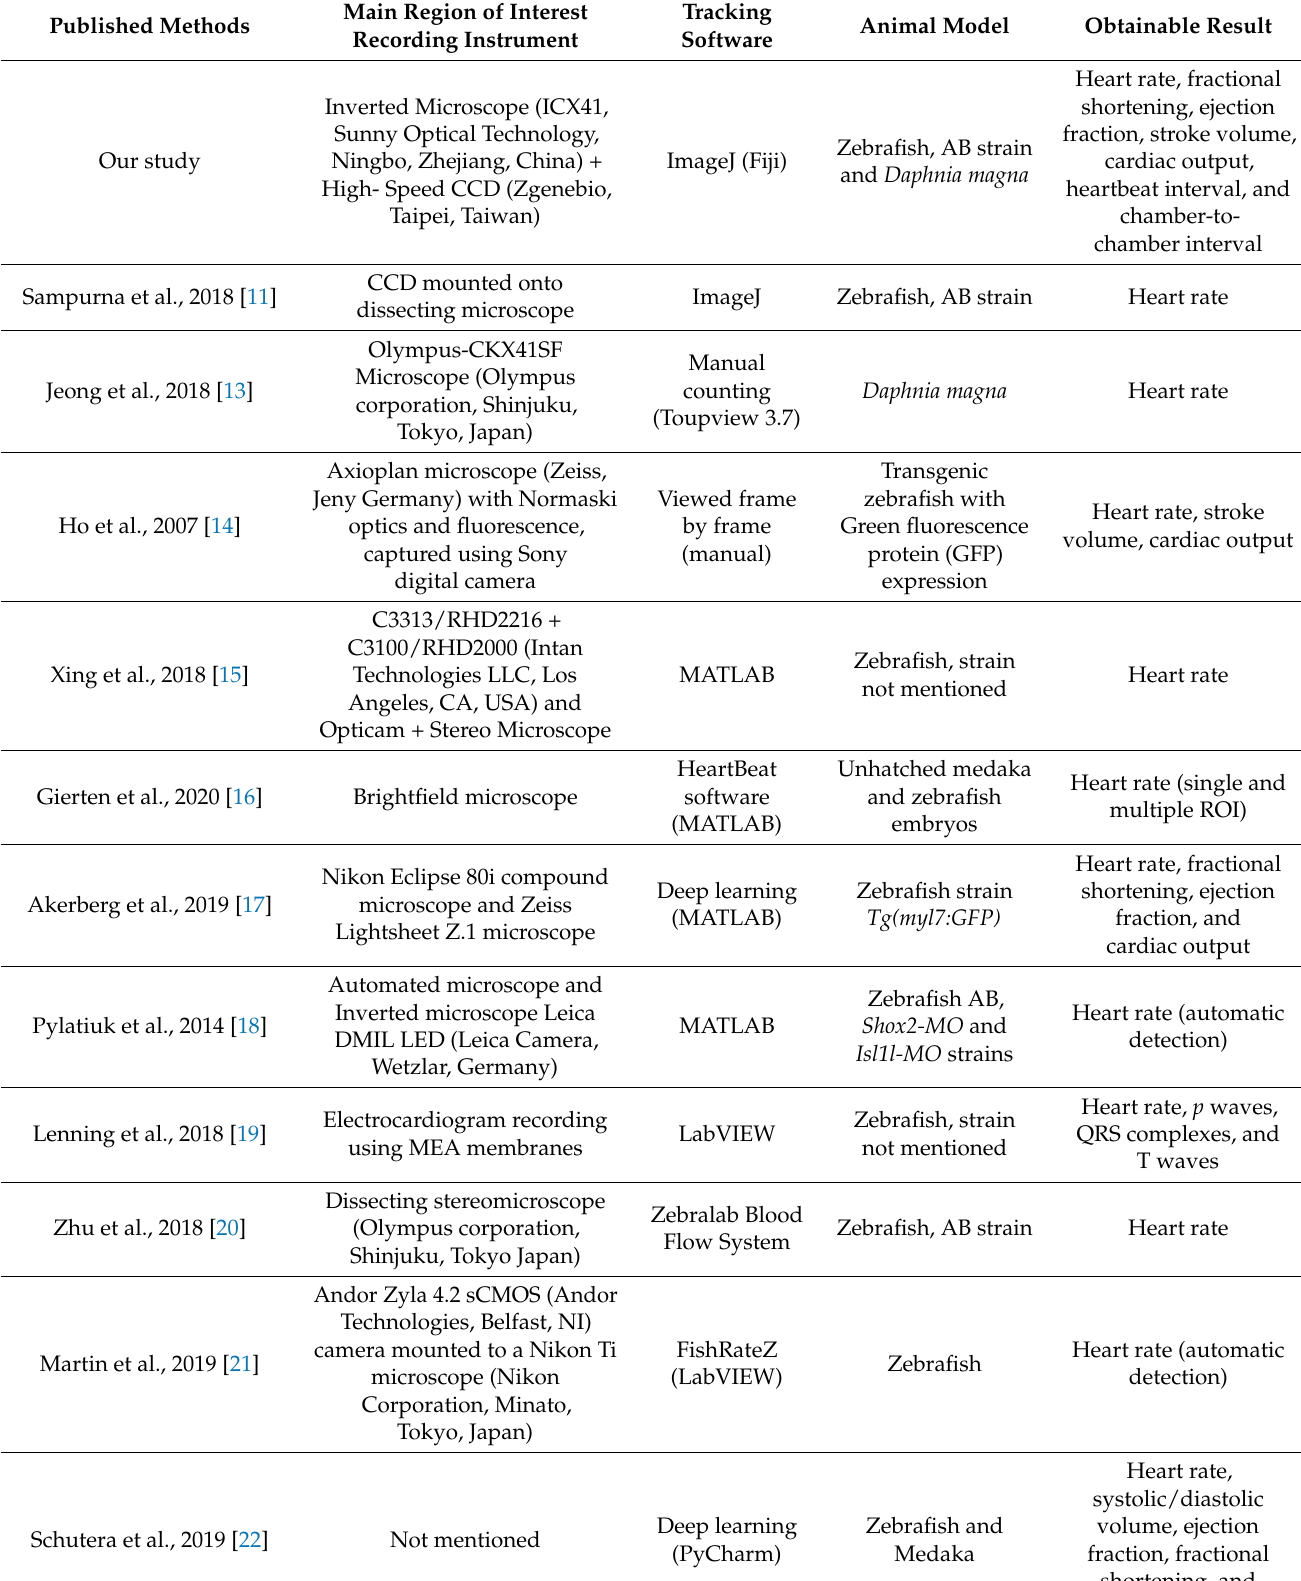
Table 1. Comparison of heartbeat measurement methods in zebrafish